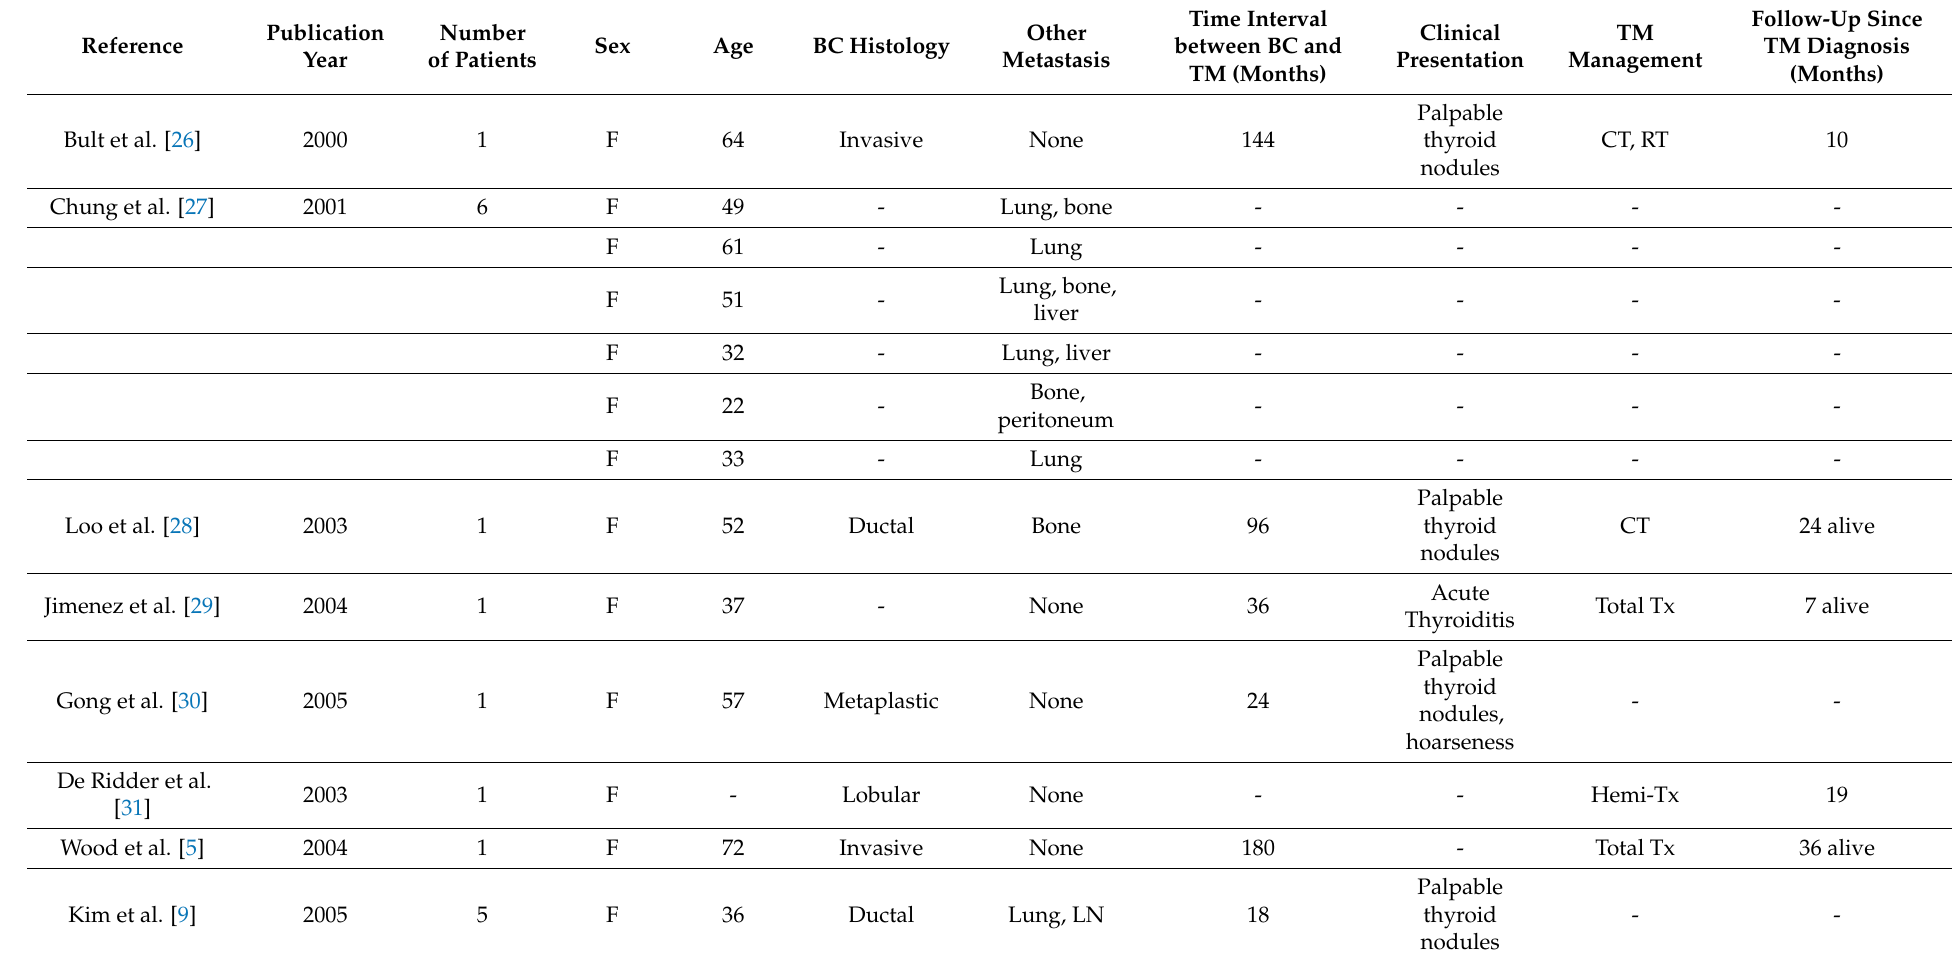
Table 2. Summary of clinical characteristics of thyroid metastasis from breast cancer reported in the literature since